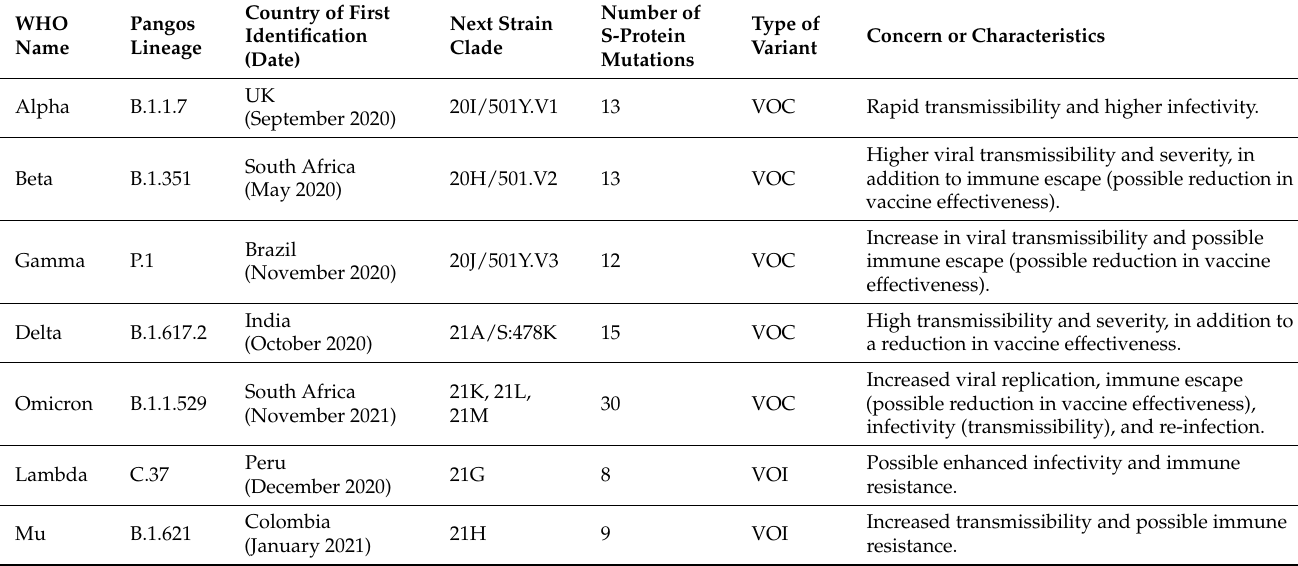
Table 1. The characteristics of the main SARS-CoV-2 variants of concern or interest, according to WHO